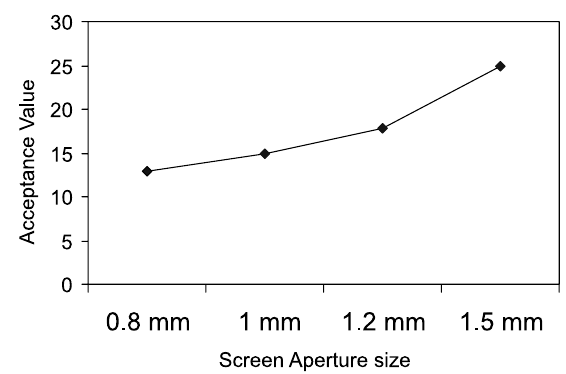
FIGURE 8 - Effect of extrusion screen aperture size (0.8 mm, 1.0 mm, 1.2 mm & 1.5 mm) on Acceptance Value of tablets.